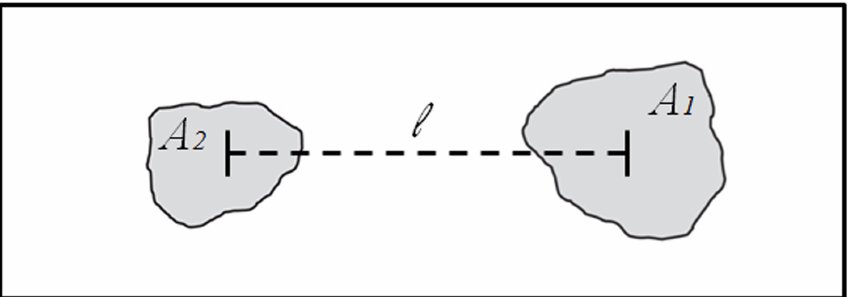
Figure 1. The fault model: a rectangular fault with two asperities with areas A 1 and A 2 respectively and distance (cid:96) between asperity